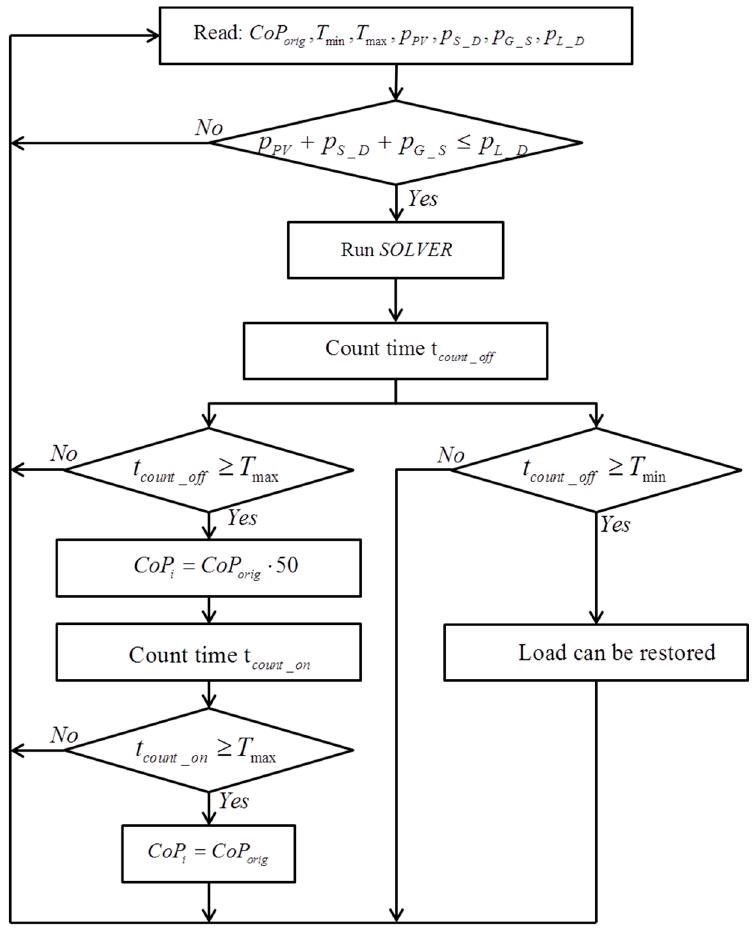
Figure 5. Load shedding/restoration optimization flow scheme.